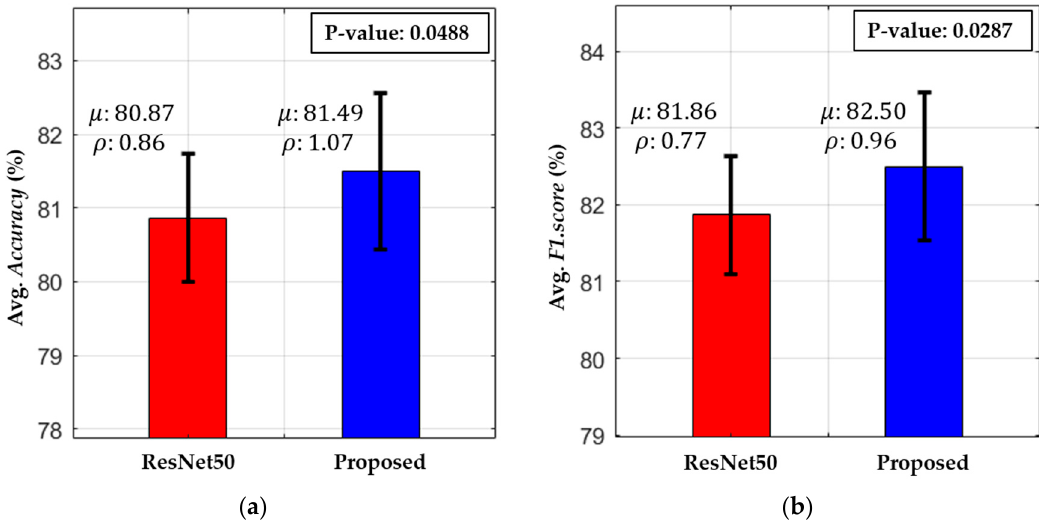
Figure 12. T-test plot of our proposed and the second-best model (ResNet50 [42]) in terms of (a) average accuracy and (b) average F1-Score (unit: %).